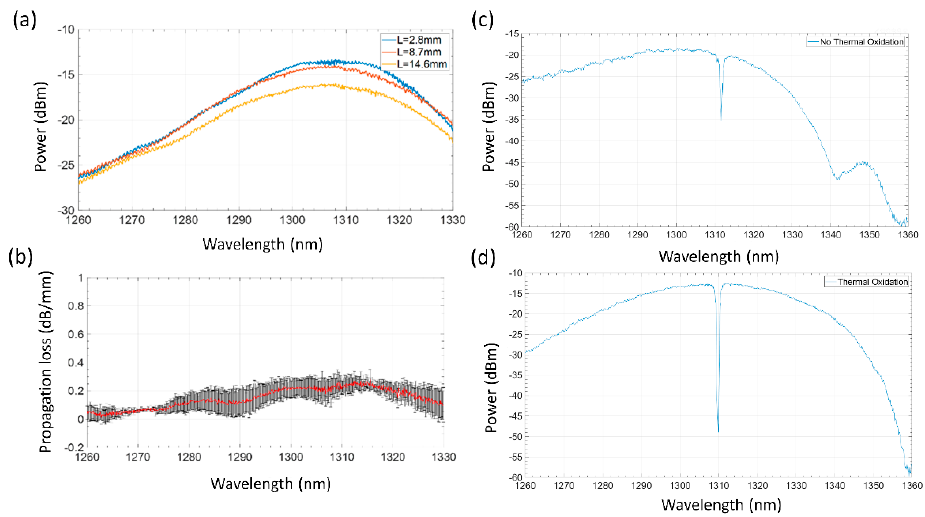
Figure 8. ( a ) Transmission spectra of three waveguides having different lengths (L = 2.8 mm, 8.7 mm and 14.6 mm) for cut-back analysis of the propagation losses. ( b ) Propagation losses (dB/mm) of rib waveguides extracted with the least mean square method, allowing us to find the best linear regression by minimizing the sum of squared errors. The propa- gation losses are reduced to 0.15 ± 0.05 dB/mm (mean value) after our developed thermal oxidation process was applied. The error bars on the propagation loss values at each wavelength arise from the goodness of the linear fit with respect to the measured data set. ( c , d ) Comparison of slow-light waveguide band gap ( c ) before and ( d ) after our thermal oxidation process was applied. The slow-light waveguides featured a much deeper band gap after the oxidation, which is another clear sign of the achieved sidewall roughness